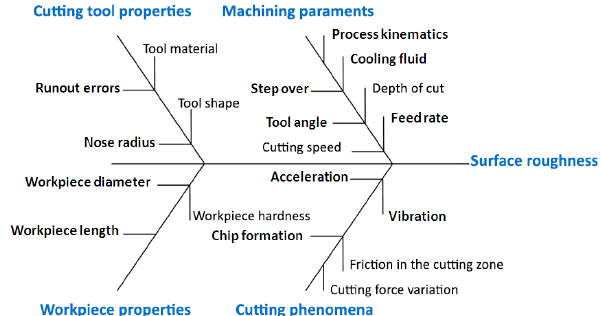
Figure 1. Fishbone diagram of the parameters that affect surface roughness [3].